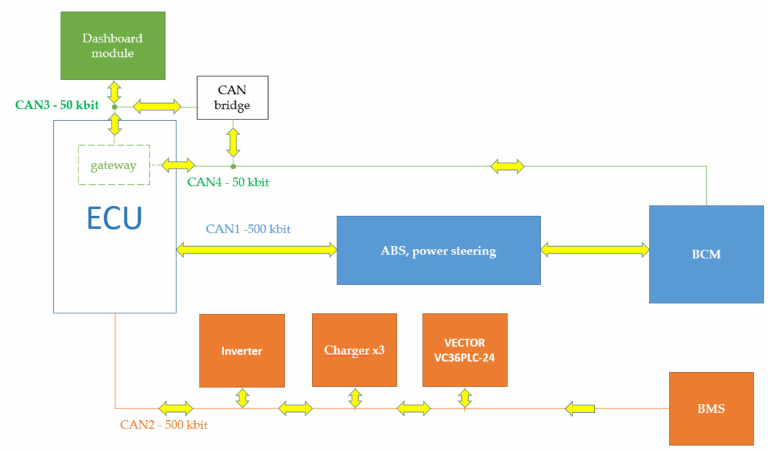
Figure 5. ECU controller and the controller area network (CAN) bus architecture of the